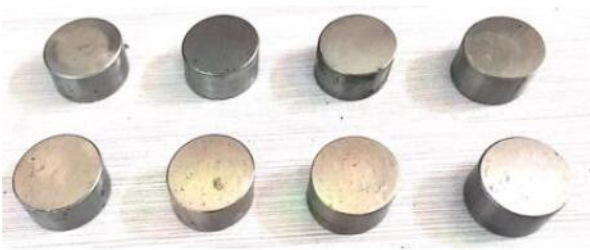
Figure 16. Steel